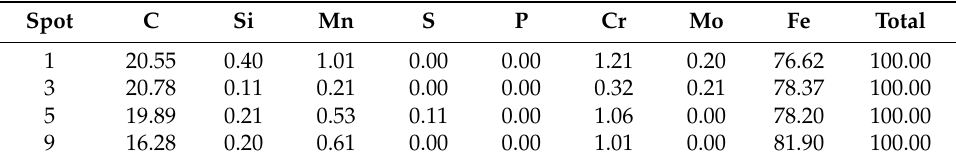
Table 3. Distribution of elemental composition in the corresponding areas indicated in Figure 6a–c (in at